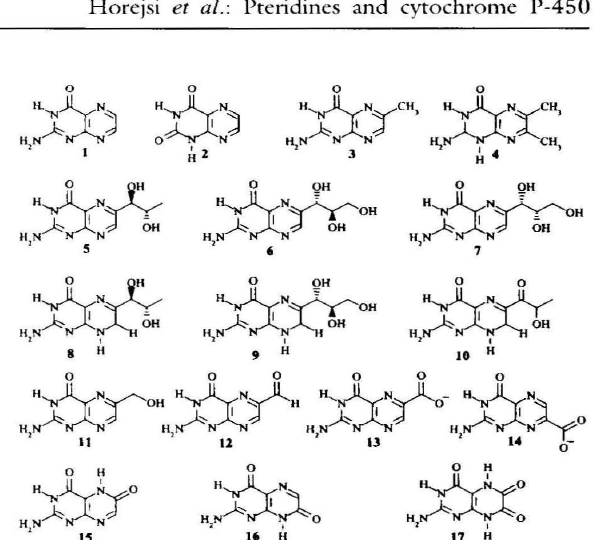
Figure 1. Chemical stmctures of the pteridines